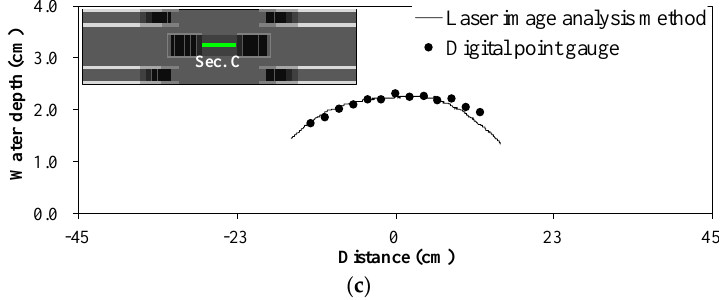
Figure 8. Comparison between water depth calculation results and measurements: ( a ) Sec. A; ( b ) Sec. B; ( c ) Sec. C.